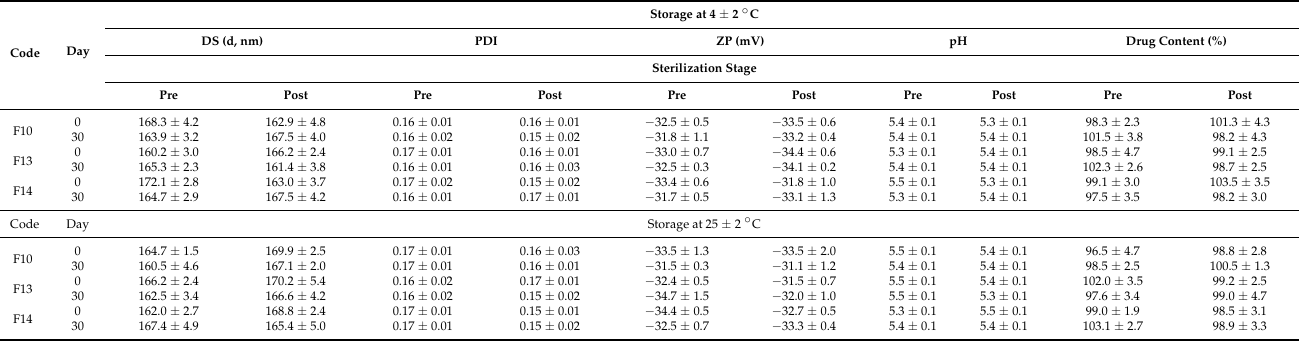
Table 5. Effect of autoclaving on the physicochemical characteristics of F10, F13, and F14 formulations before and after sterilization over one month of storage at 4 ◦ C and 25 ◦ C (mean ± SD, n =